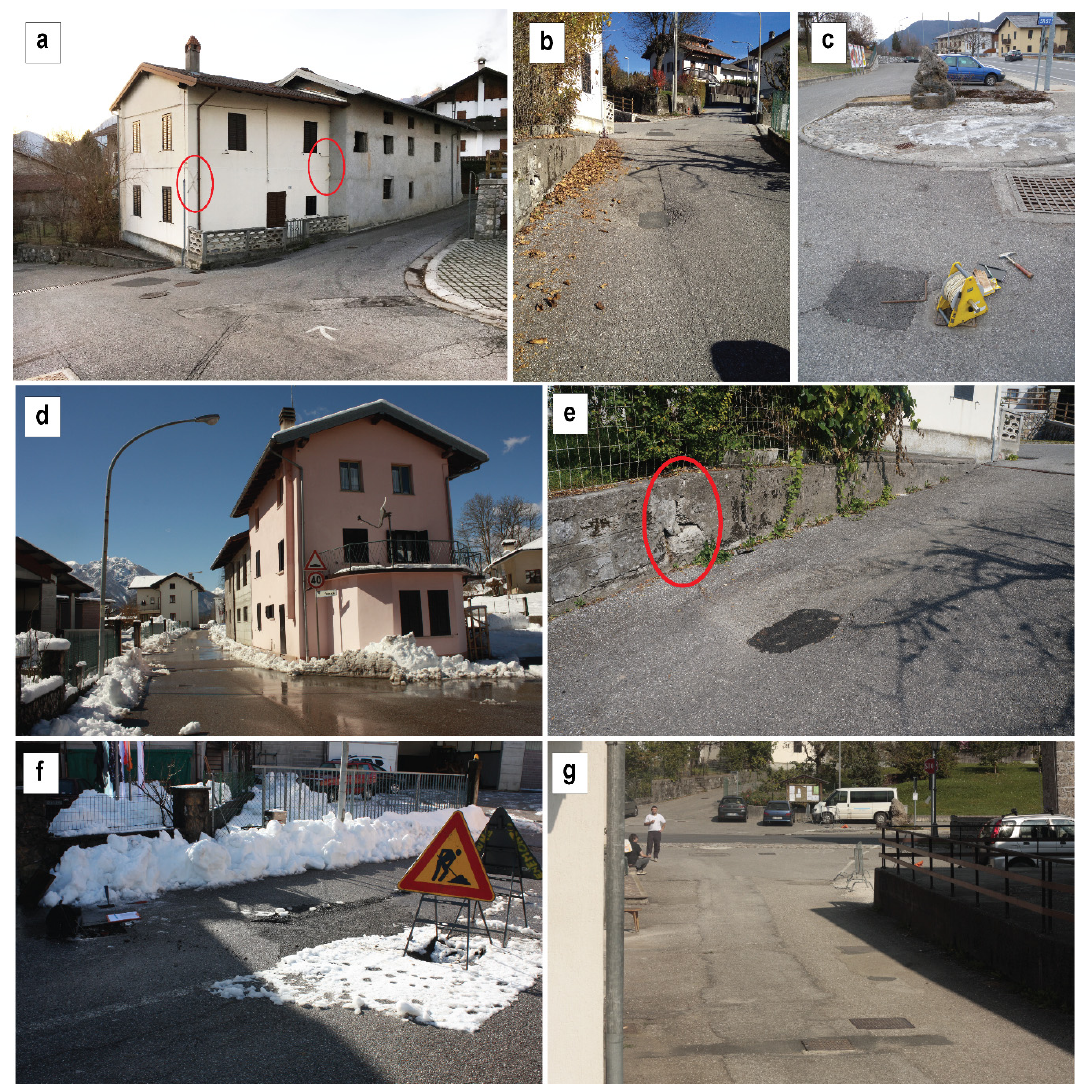
Figure 16. Collage of photos with evidence of breaks and fissures of the road pavement, sidewalks, and containment walls. ( a – g ) letters identify the damaged sites and have a corresponding position in Figure 17. ( a ) Red ellipses highlight the presence of strands reinforcing and linking the building; ( e ) cracks on the sidewall correspond to an active sinkhole.